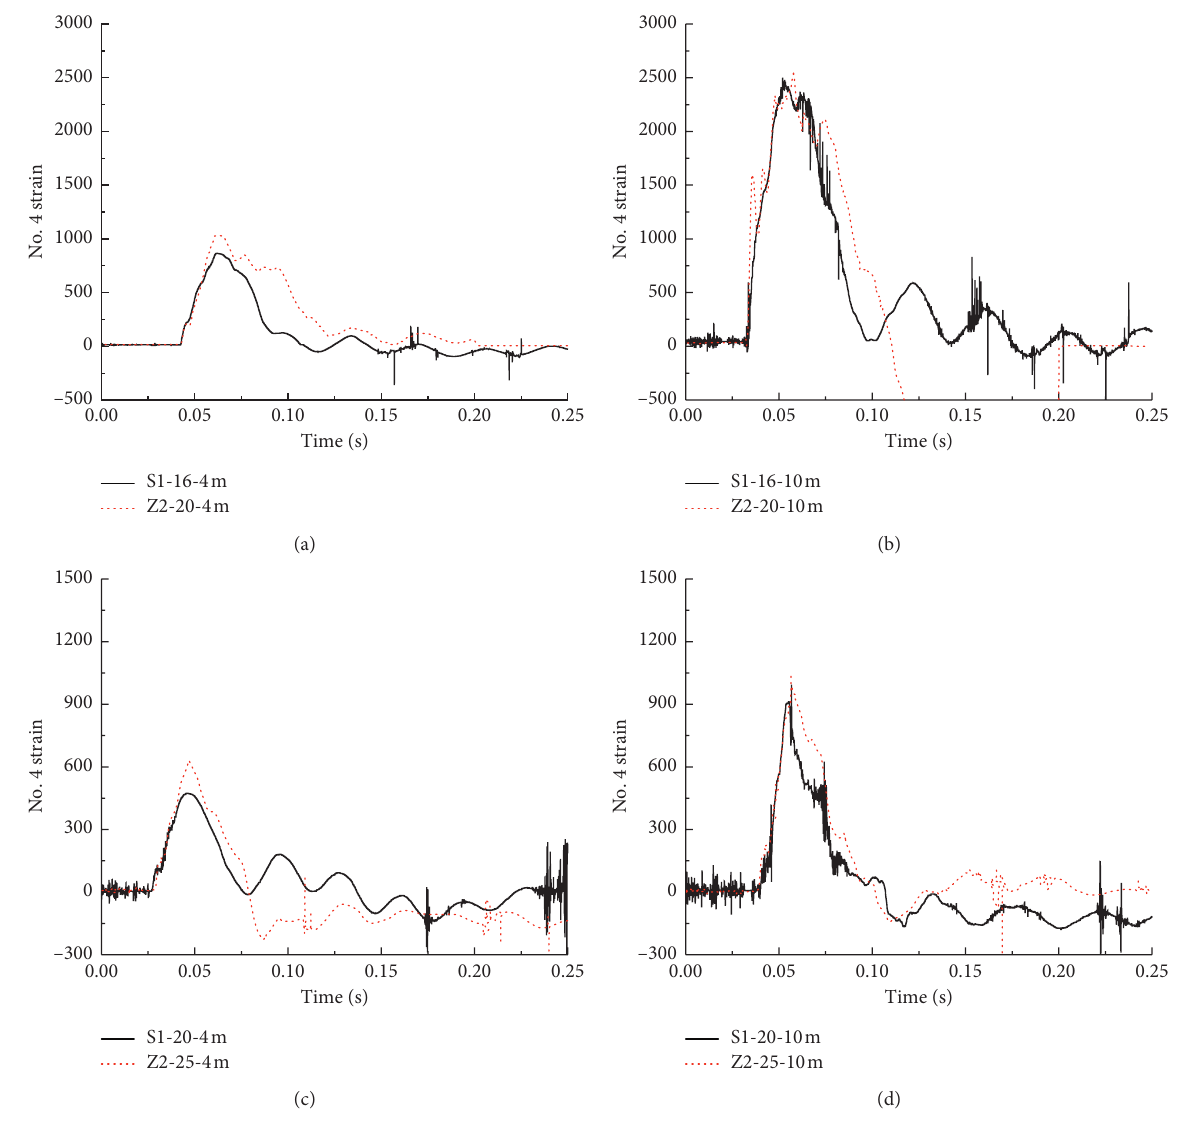
Figure 14: Time history curve of strain of the #4 steel bar when the drop hammer is lifted to 4m and 10m. Table 9: Peak strain and stress test results of #4